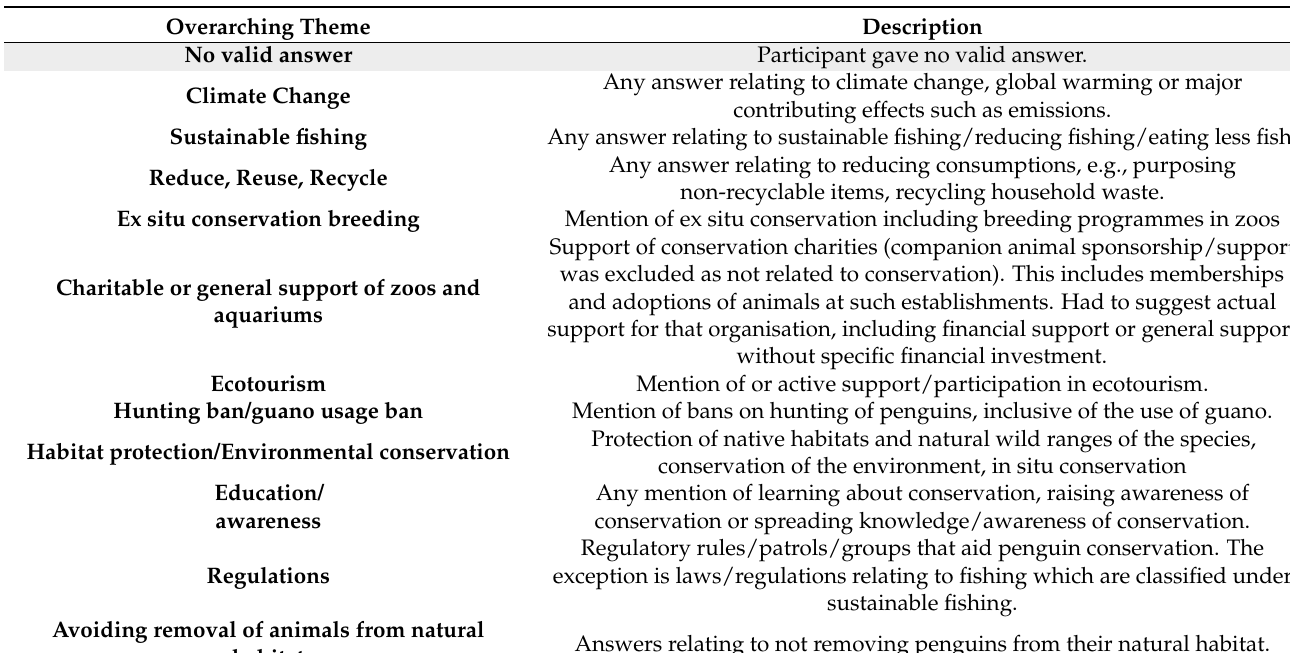
Table 2. Overarching themes used to categorise the responses to open ended questions and their definitions used as criteria to determine how the answers were